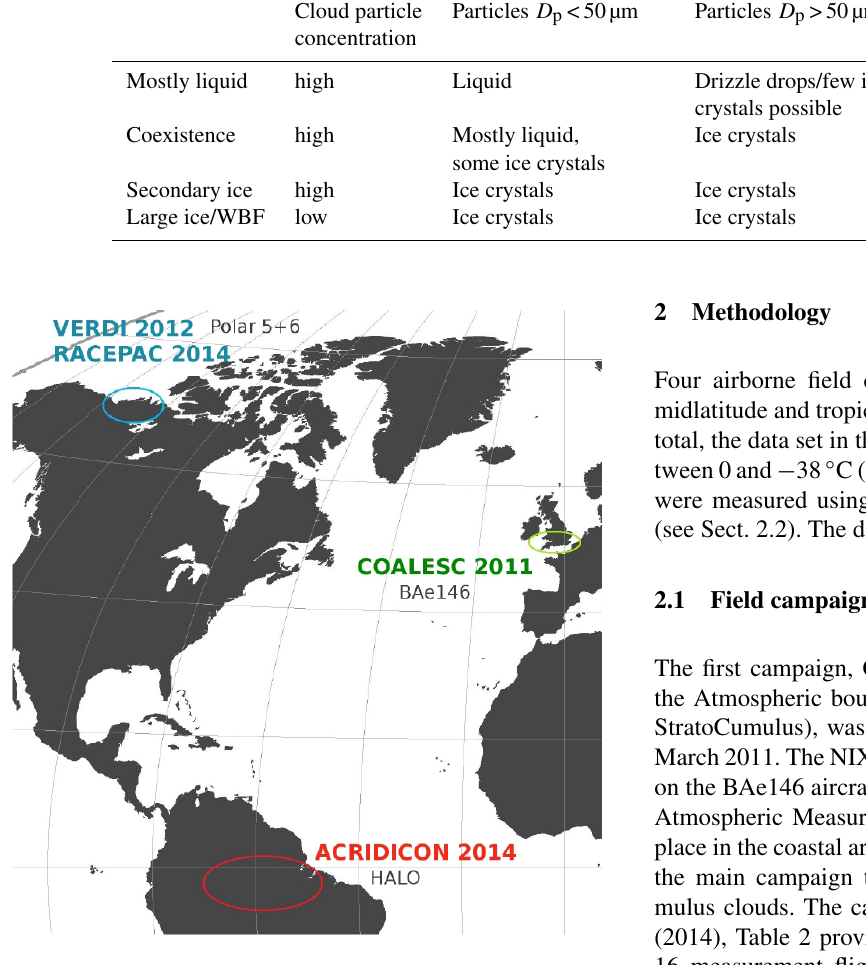
Figure 3. Locations of the campaigns presented in this paper.